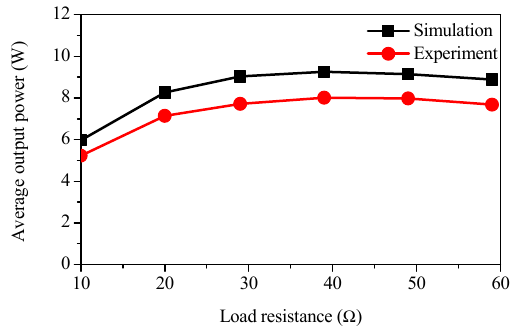
Figure 8. Average power according to various load resistances.